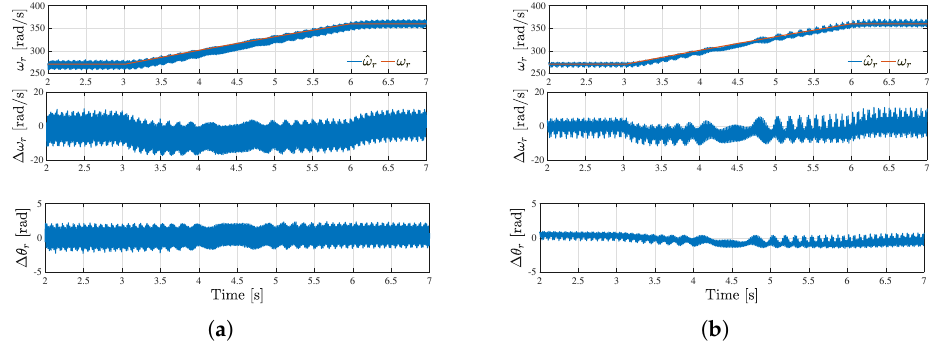
Figure 7. Simulation results during a steady change in rotor speed ( a ) Simulations results from the proposed SMC-MRAS estimator and ( b ) simulations results from the PI-MRAS estimator. From t = 3 s to t = 6 s, the rotor speed increased steadily from 270 to 360 rad/s. The speed error of both MRAS estimators is less than 20 rad/s, which is satisfactory. The rotor angle error for both speed estimators converges to zero to confirm the fact that the performance of both MRAS estimator is